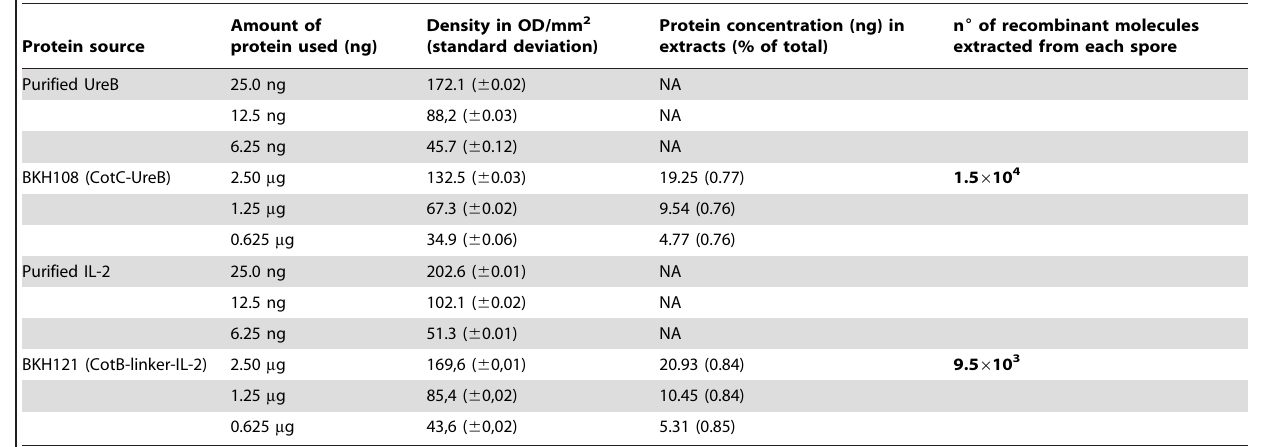
Table 3. Densitometric analysis.